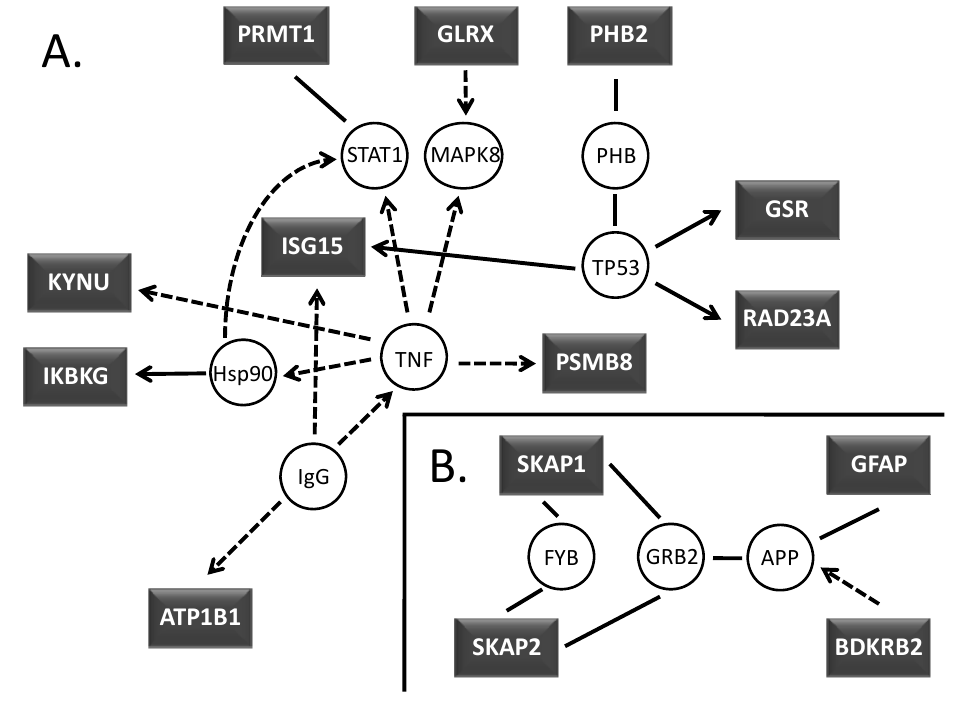
Figure 2. Network view of associated proteins created within Ingenuity Pathway Analysis software for visualizing molecular interrelationships. (A) TNF- α and TP53, (B) SKAP and GFAP associated proteins. Coloring is based on the expression values that were uploaded with the dataset. Gray indicates the molecule was part of the dataset. Lines connecting molecules indicate molecular relationships. Dashed lines indicate indirect interactions; solid lines indicate direct interactions. The style of the arrows indicates specific molecular relationships and the directionality of the